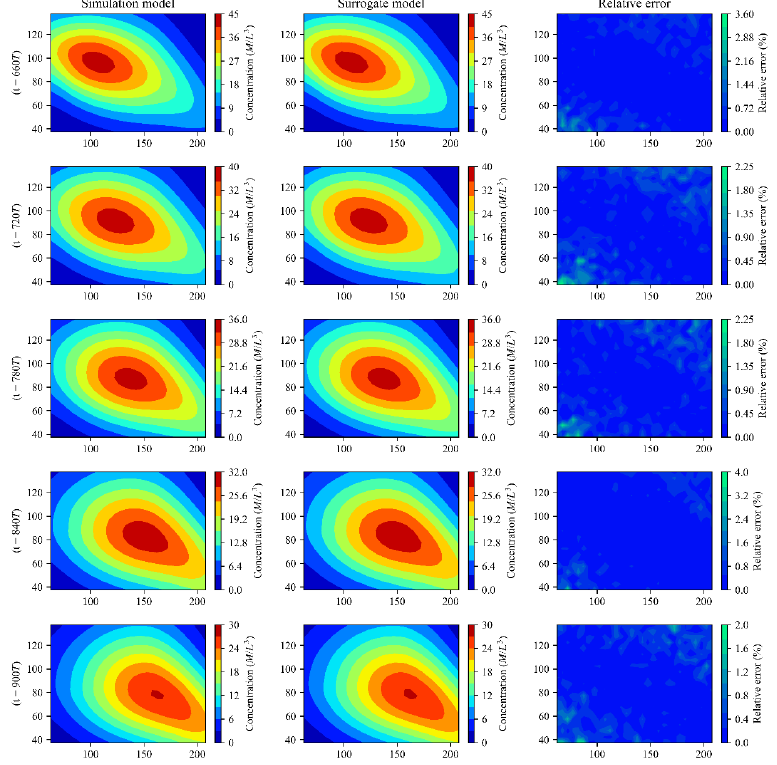
Figure 5. Output and relative error of simulation model and surrogate model for Case 2 (the x-axis and y-axis represent the length and width of the flow field, respectively).